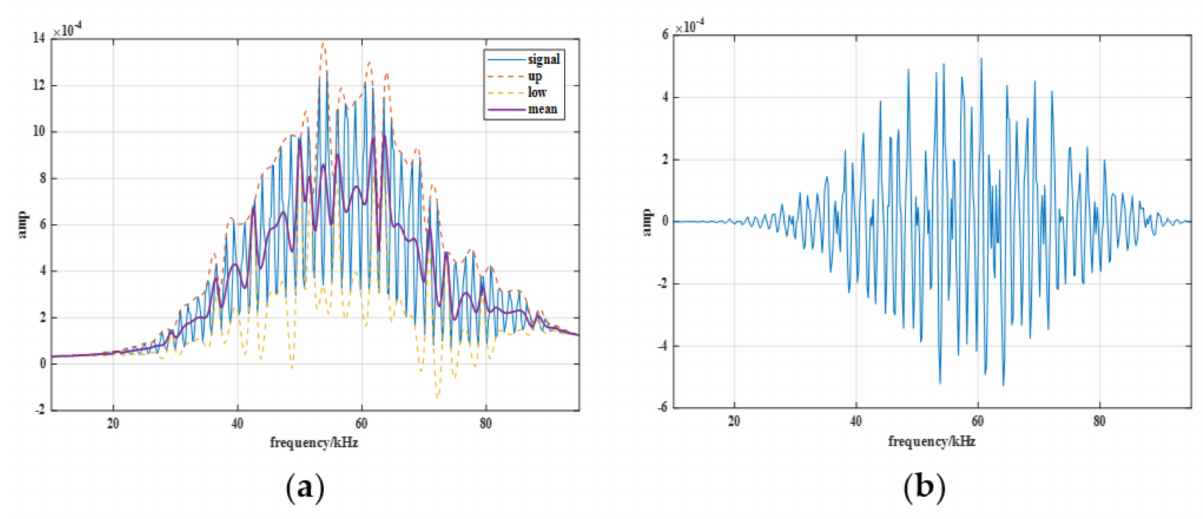
Figure 6. Fluctuation amplitude–frequency curve of fault line-mode current: ( a ) fault line-mode current peak envelope and mean curve; ( b ) fluctuation amplitude–frequency curve of the fault line-mode current after removing the mean